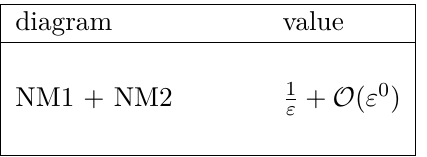
Table 1. UV divergence of the diagrams from figure 4 in units of C 2 ( R ) g